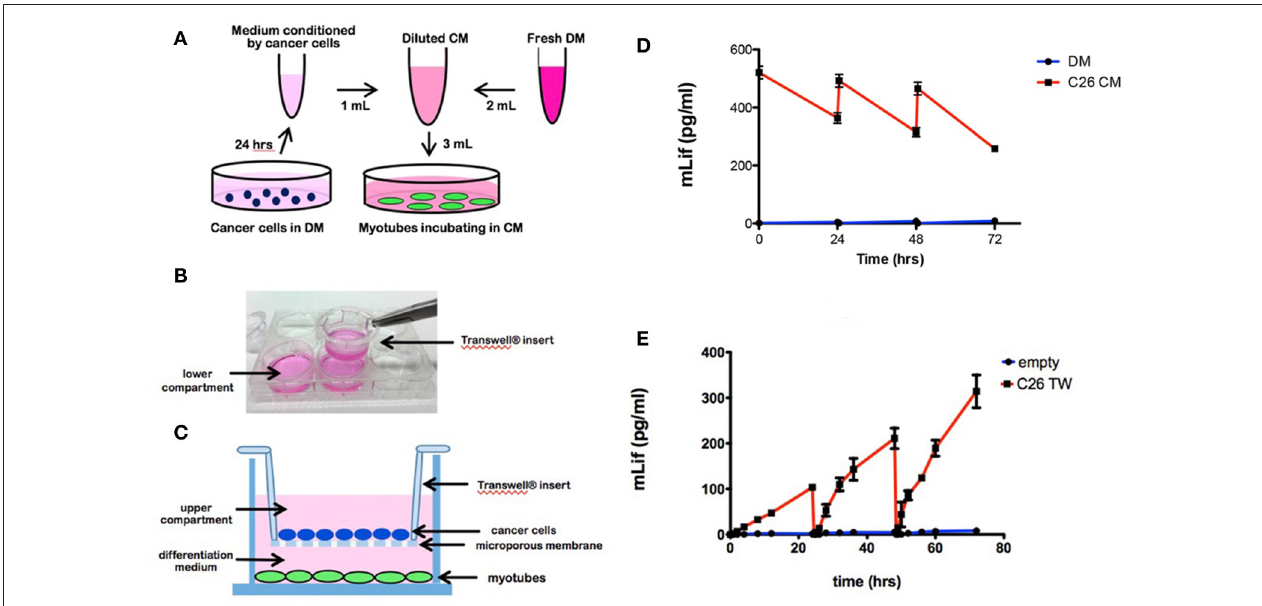
FIGURE 1 | Cell culture models of tumor cell treated myotubes and the associated LIF levels in medium. (A) Schematic drawing of the design for the conventional conditioned medium (CM) model. C26 cancer cells were incubated in differentiation medium (DM) for 24 h to produce conditioned medium. Four day-differentiated C2C12 myotubes were treated for 72 h with 33% CM in fresh DM, refreshed every 24 h. (B) Photograph of a Transwell insert being placed into a well of a 6 well plate. (C) Schematic diagram of the Transwell system with C26 cancer cells in the upper compartment and C2C12 4-day myotubes growing below (figure is redrawn from Corning website). Cancer cells were seeded on microporous membrane insert (0.4 µ m) placed into the well containing myotubes for 72 h with the upper and lower compartments containing DM, refreshed every 24 h. (D) Graph of LIF levels in medium from myotube cultures treated with DM (control) or C26 CM at the beginning and end of each 24 h period of treatment. (E) Graph of LIF levels in the lower compartment of myotube cultures with Transwell (TW) inserts seeded with C26 cells. “Empty” indicates control myotube cultures containing Transwell inserts without C26